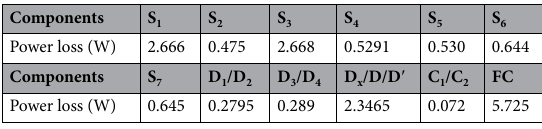
Table 6. Power loss of each component for 80 Ω + 100 mH.